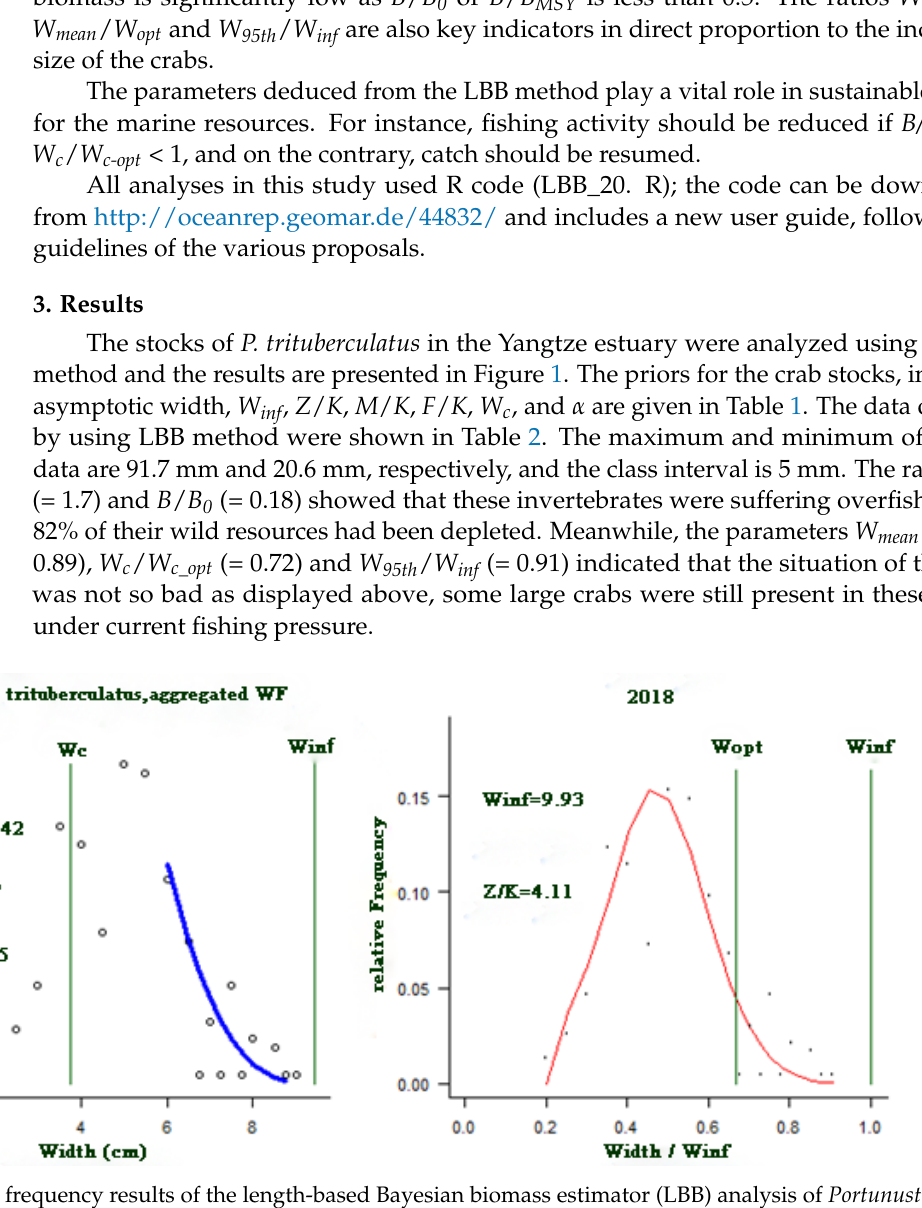
Figure 1. The width and frequency results of the length-based Bayesian biomass estimator (LBB) analysis of Portunus- trituberculatus in the Yangtze Estuary. The left curve manifests the fitness of the model to the width data of the swimming crab, while the right curve is the estimation of the LBB method; the peak point of the right curve is on the left of Wopt and the Z/K in the right curve is greater than the value in the left curve, indicating that overfishing occurs for the species. W c is the width of 50% of the crabs captured, W inf is the asymptotic width of the P. trituberculatus and W opt is the width at which the maximum catch is available.